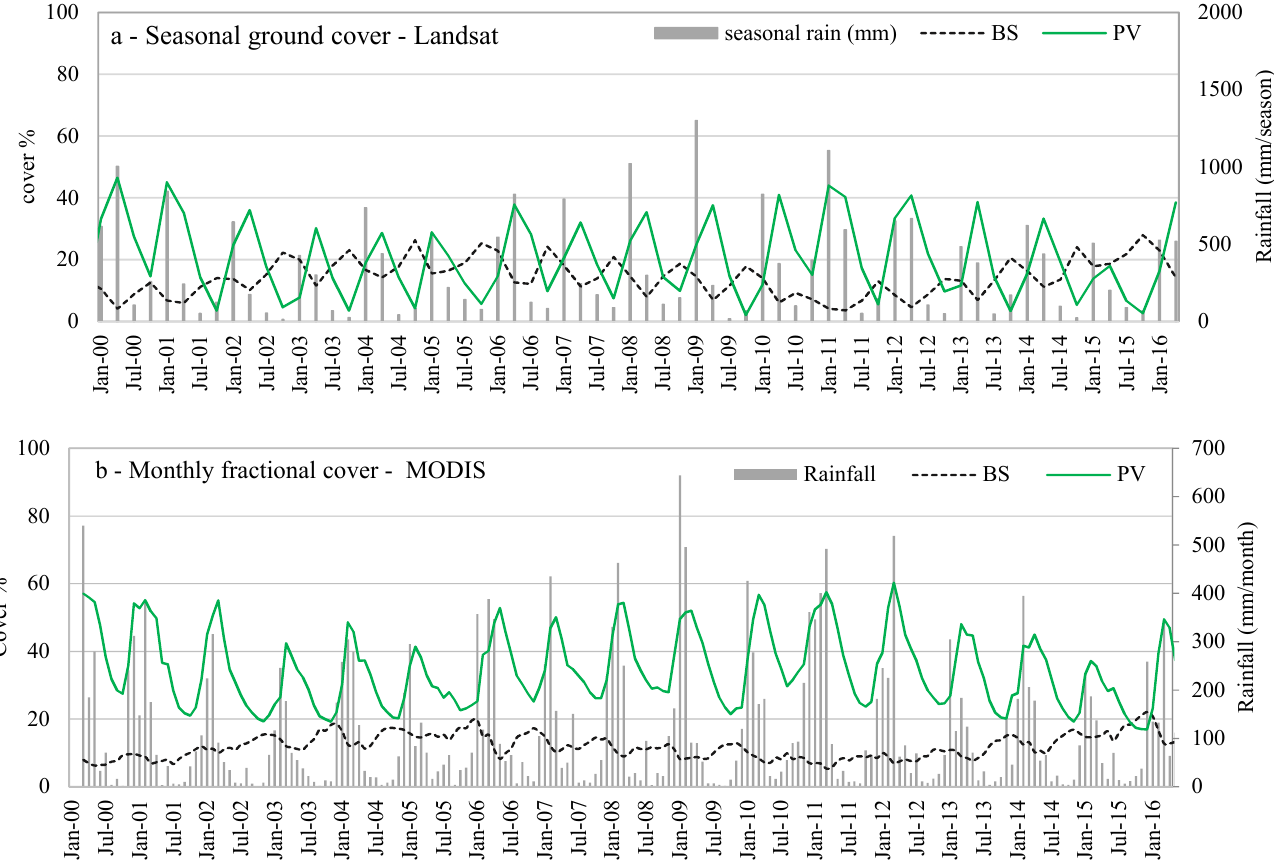
Figure 6. ( a ) Seasonal and monthly ground cover changes in the Upper Burdekin. Part a—Seasonal Bare Soil (BS) of Photosynthetic Vegetation (PV) cover from Department of Science, Information Technology and Innovation remote sensing group ground cover data [50] from 2000 to 2016. Summer: December to February; Autumn: March to May; Winter: June to August; and Spring: September to November; ( b ) Monthly fractional cover extracted from MODIS datasets [45] during 2000–2016.